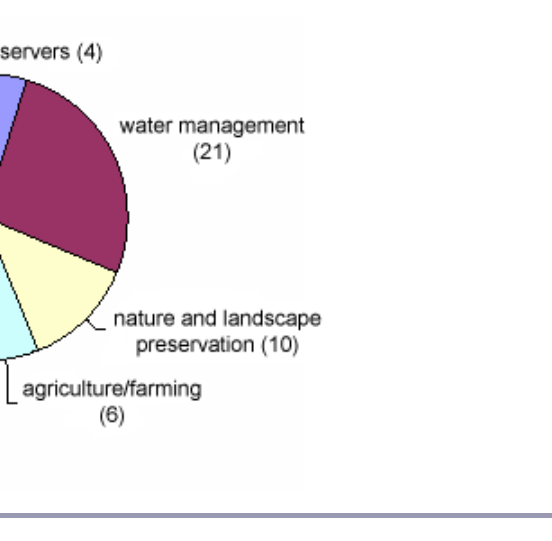
Fig. 3 . Interests represented at the workshops (includes observers [i.e., researchers] and moderators). Number of participants are shown in brackets, and were divided up over the three workshops. (Source: Seecon Deutschland GmbH et al.